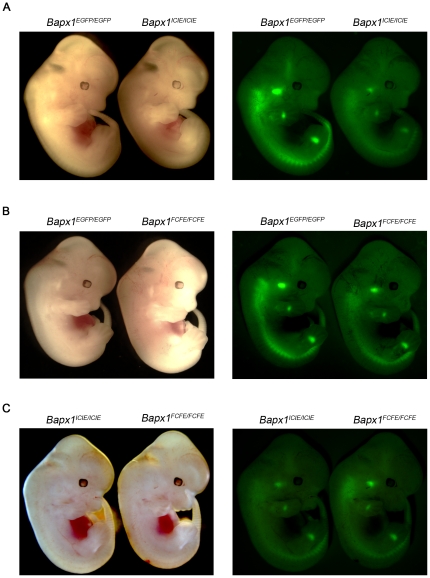
EGFP expression mediated by IRES and F2A at the Bapx1 locus.Homozygous E12.5 Bapx1EGFP/EGFP, Bapx1ICIE/ICIE and Bapx1FCFE/FCFE embryos imaged under white light (left panel) and fluorescence microscope (right panel). EGFP expression recapitulates Bapx1 expression domains in all three Bapx1-targeted mouse lines. (a) In Bapx1EGFP/EGFP vs. Bapx1ICIE/ICIE, the former clearly showed brighter fluorescence. (b) In Bapx1EGFP/EGFP vs. Bapx1FCFE/FCFE, both had comparable fluorescence intensities. (c) In Bapx1ICIE/ICIE vs. Bapx1FCFE/FCFE, the latter displayed a slightly higher EGFP fluorescence.